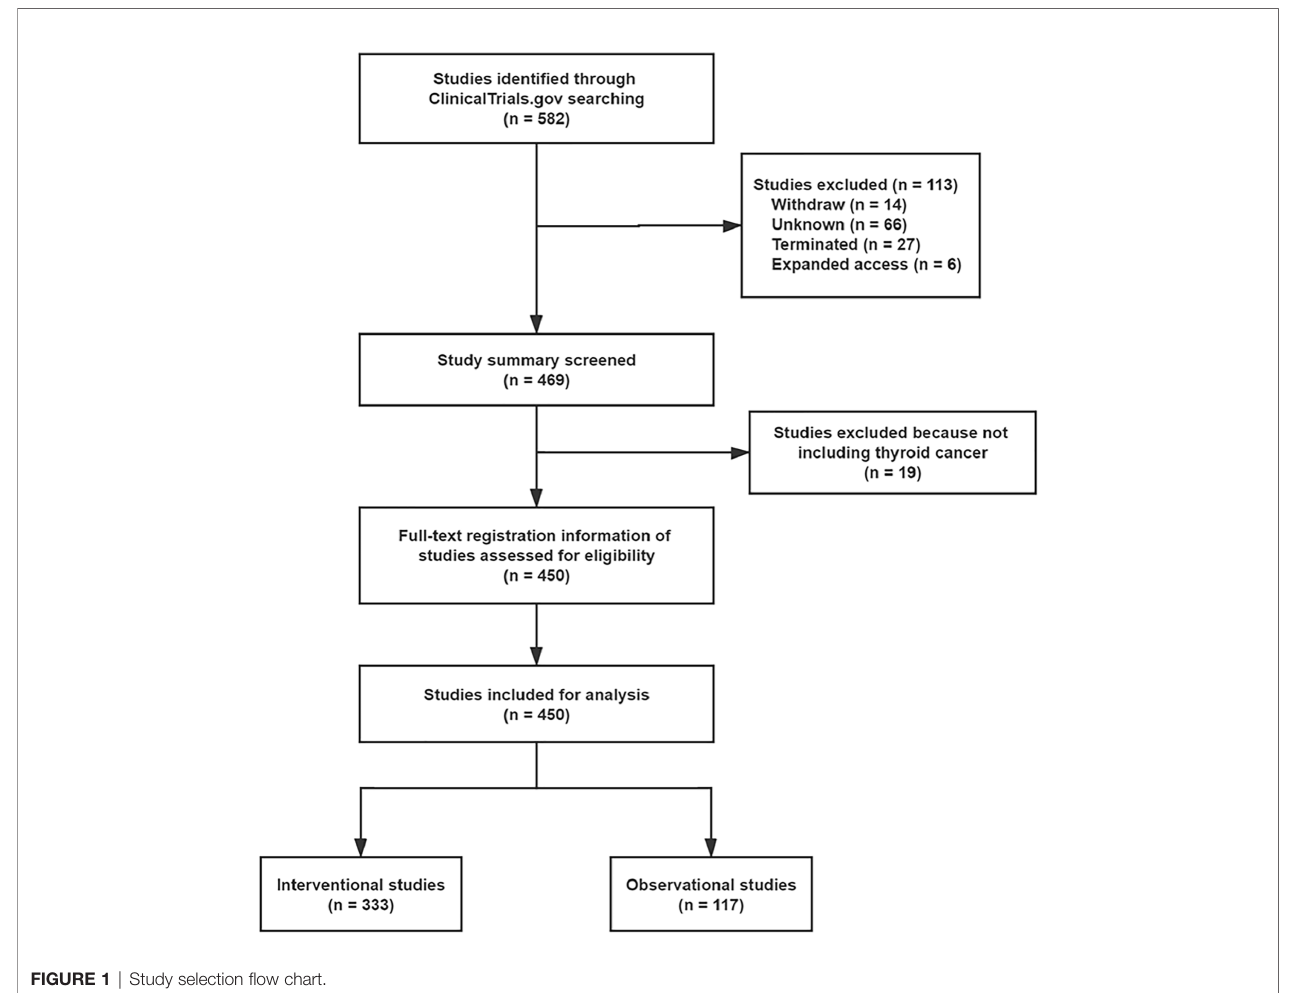
FIGURE 1 | Study selection fl ow chart.